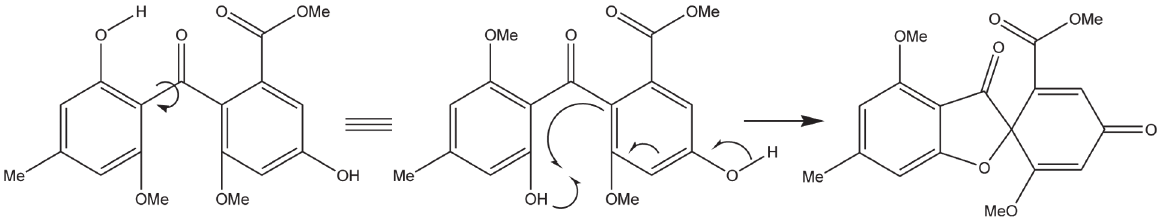
Figure 2 - trypacidin formation through oxidative coupling of monomethylsulochrin.